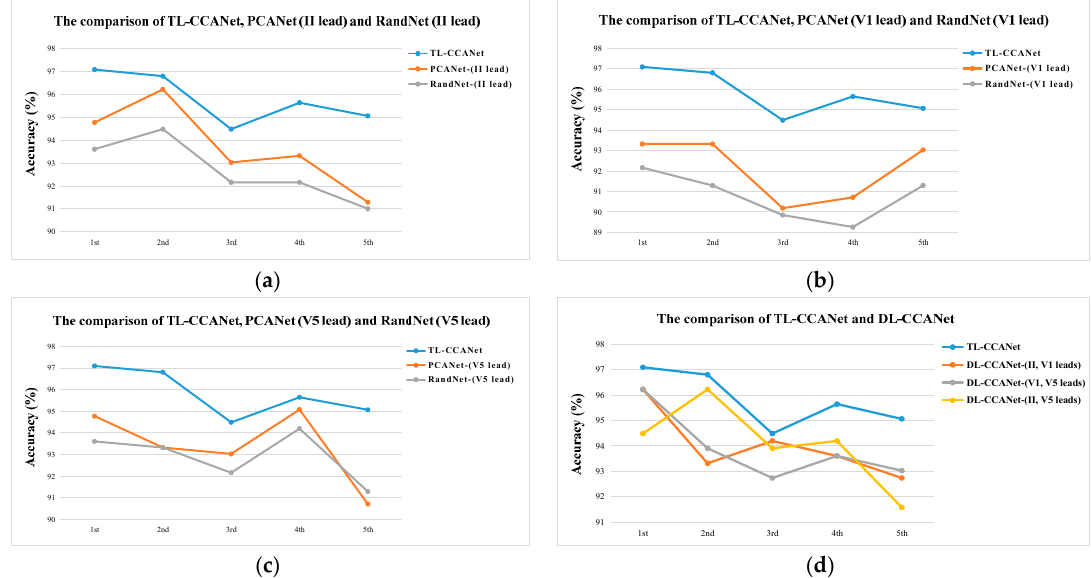
Figure 6. The comparison of the ECG classification performances of each fold ( a ) TL-CCANet, DL- CCANet, PCANet, and RandNet on INCART database. ( b ) TL-CCANet, PCANet(II) and RandNet(II); ( c ) TL-CCANet, PCANet(V1) and RandNet(V1); ( d ) TL-CCANet, PCANet(V5) and RandNet(V5).